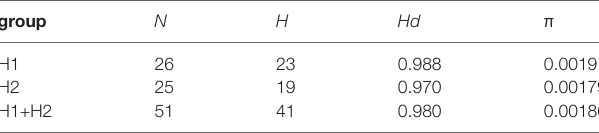
TABLE 3 | Summary genetic statistics of each local group of G. haimaensis based on MCD sequences. group